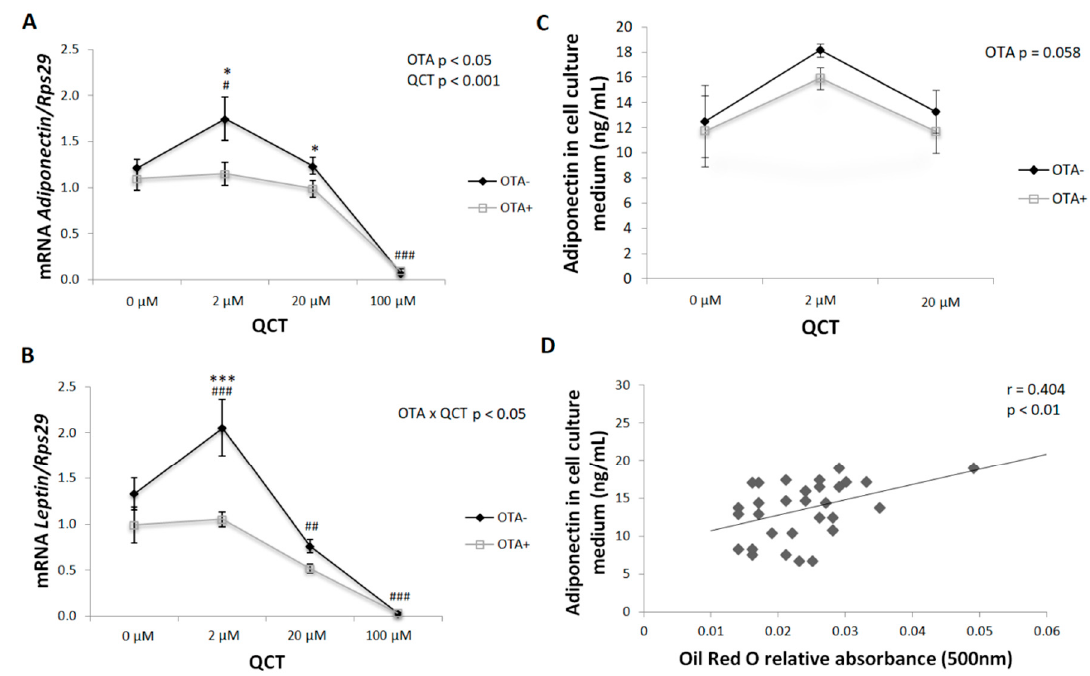
Figure 4. Gene expression of adipokines in differentiated primary rat preadipocytes cultured with (OTA+) or without the addition of ochratoxin A (OTA-) in cell culture medium and with the addition of quercetin (QCT) at various concentrations. The mRNA expression of adiponectin ( A ) and leptin ( B ) was determined by real-time PCR. Data were normalized to the gene expression of 40S ribosomal protein S29 (Rps29), the expression of which was not altered by the treatments. The amount of adiponectin released to the cell culture medium ( C ) was determined using a commercially available ELISA kit. The results, presented as mean ± mean error (SEM), were analyzed by two-way ANOVA with factors QCT and OTA, followed by Bonferroni post-hoc test. Correlation between cell culture adiponectin content and Oil Red O relative absorbance was analyzed using the Pearson correlation test ( D ). The level of statistical significance considered for factor OTA was * p < 0.05; *** p < 0.001, and for factor QCT # p < 0.05; ## p < 0.01; ### p < 0.001.